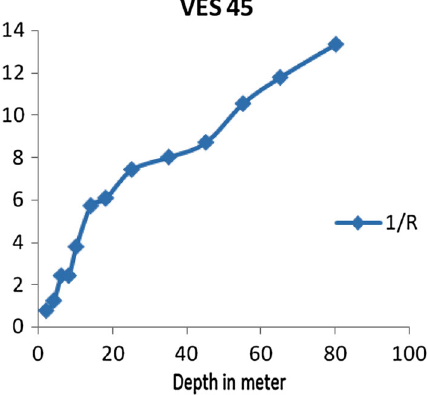
Fig. 7 Representative resistivity curve obtained by the inverse slope method from Dhule